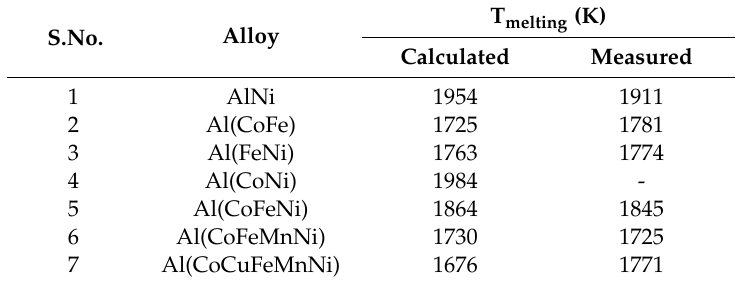
Table 3. Comparison of calculated and measured (DTA) melting points of pseudo-binary aluminides. S.No.